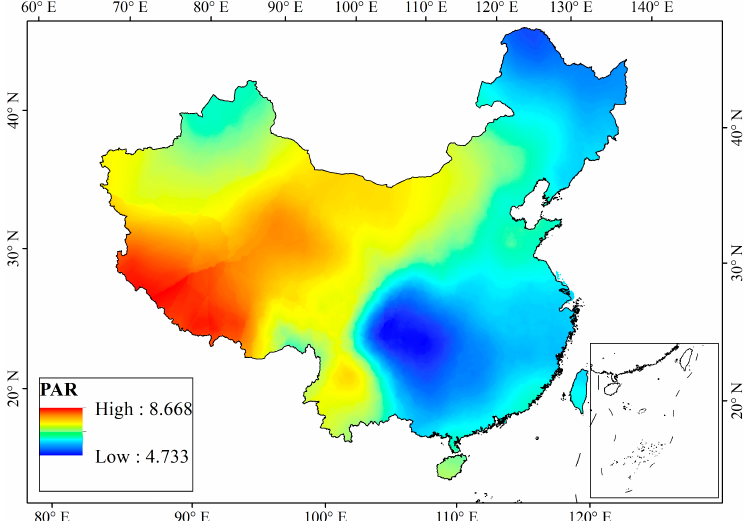
Figure 11. Annual mean PAR (MJ m − 2 day − 1 ) over mainland China.